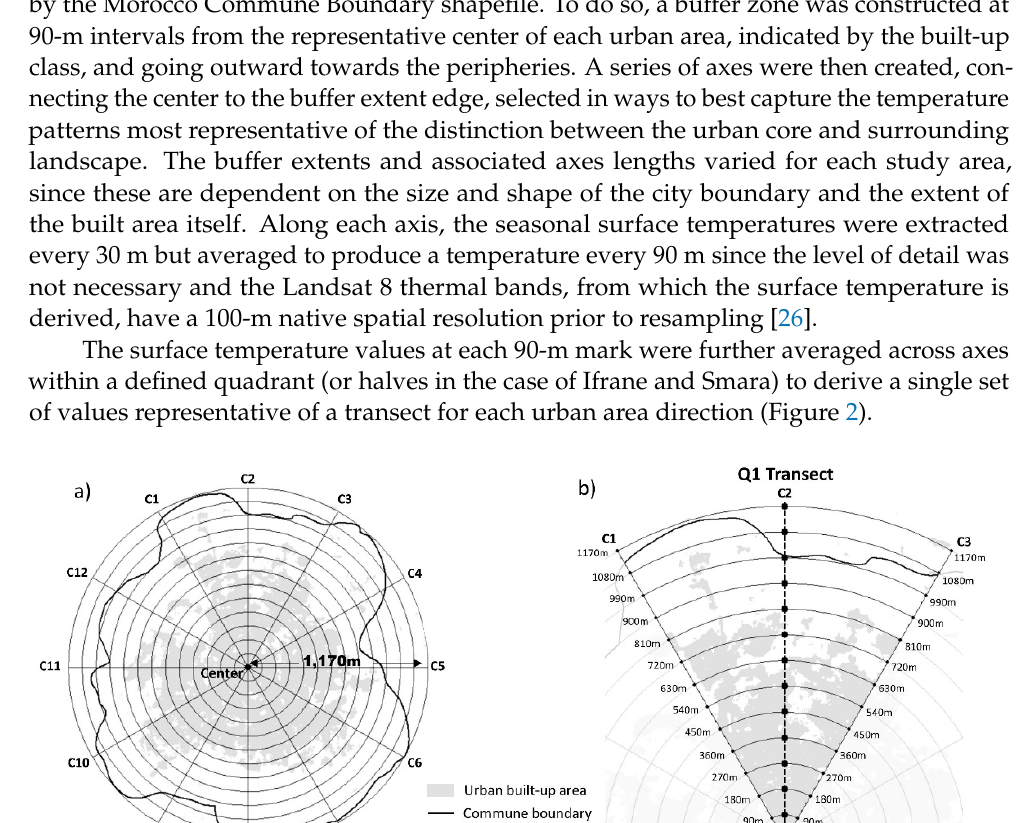
Figure 1. Urban heat island study areas. ( a – e ) Five cities in different climate zones of Morocco shown as 2016 Landsat 8 OLI false-color infrared images (bands 5,4,3) to distinguish built-up from vegetated areas. The scale bar is associated with ( a – e ), all of which are displayed in relative sizes.